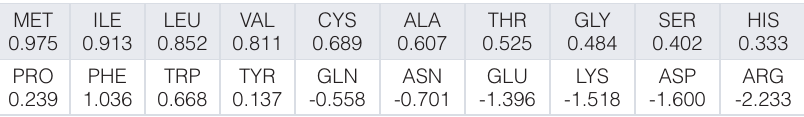
are colored in blue: dark blue for positively charged residues, medium blue for negatively charged residues and light blue for amides. We now show the PAGAL representation of a few AH